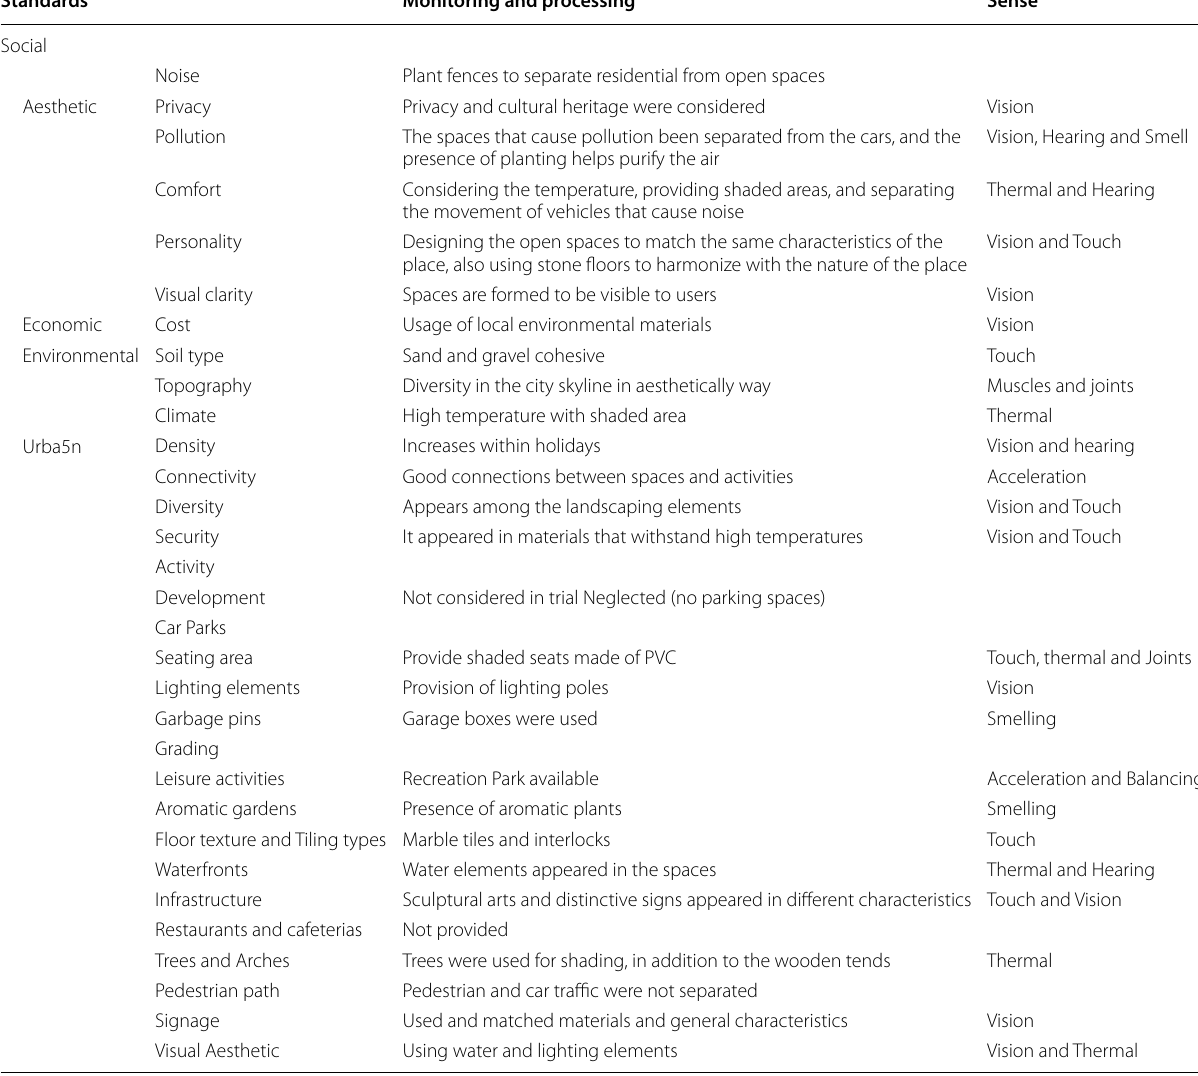
Table 4 Design criteria considered when analyzing spaces in Jeddah